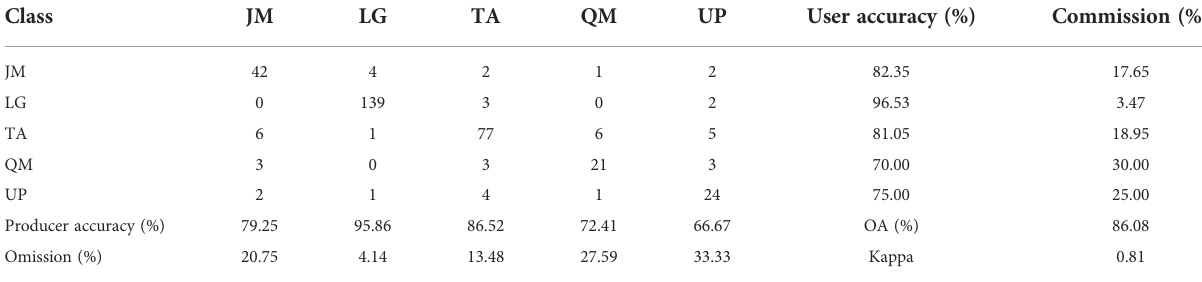
TABLE 3 Optimal results of tree species identi fi cation and accuracy indices based on HSI features.